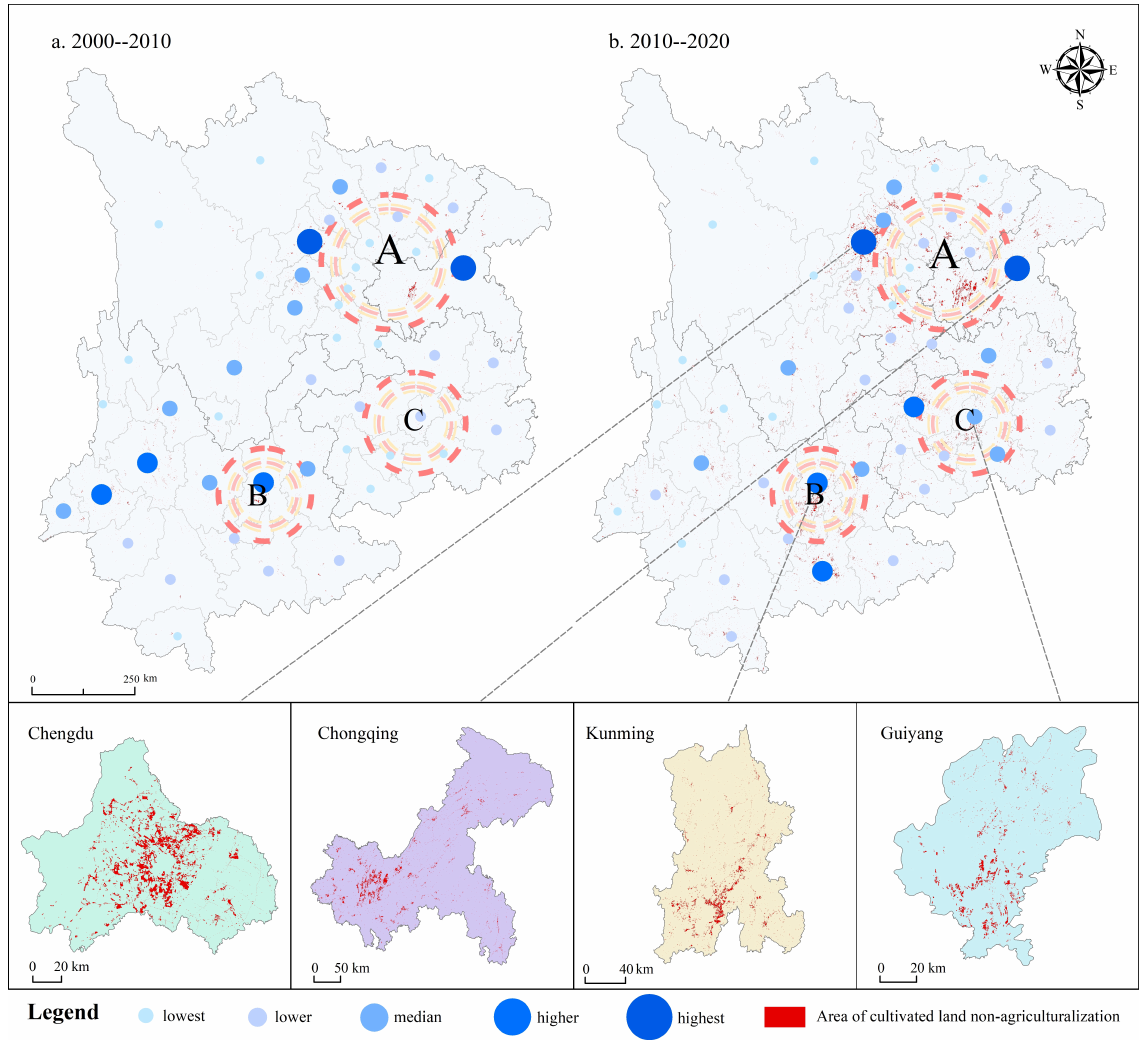
Figure 4. The grade map for the non-agriculturalization area of cultivated land. ( a ) Spatial distribution of the level of cultivated land non-agriculturalization during 2000–2010, ( b ) Spatial distribution of the level of cultivated land non-agriculturalization during